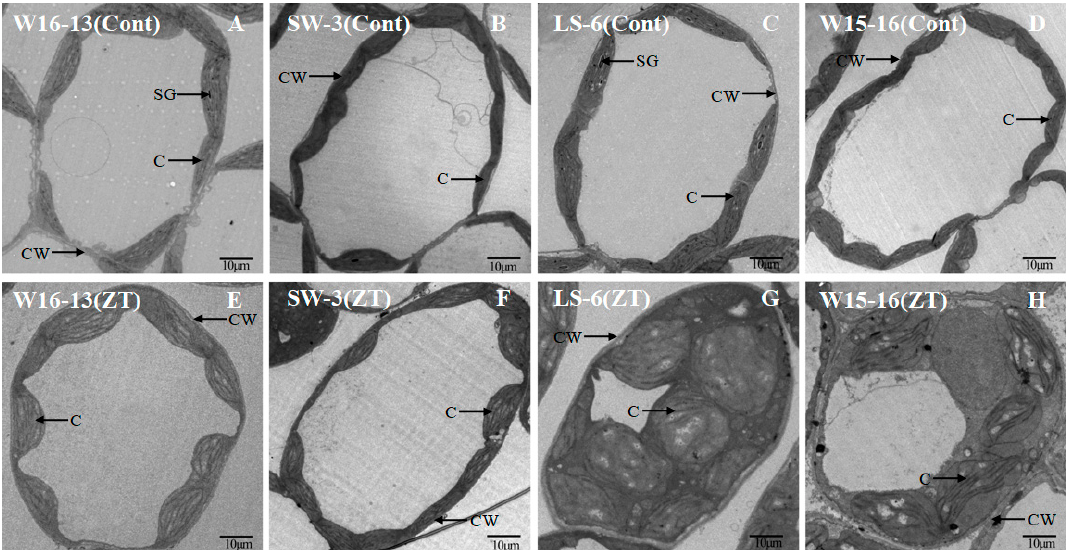
Figure 12. Transmission electron micrographs showing changes in ultrastructure of mesophyll cell of wucai seedlings under cold stress. Cont [25/18 °C(d/n)] ( A – D ), ZT [0/ − 6 °C (d/n)] stress treatment ( E – H ). CW: cell wall, SG: starch globule, C: chloroplast.